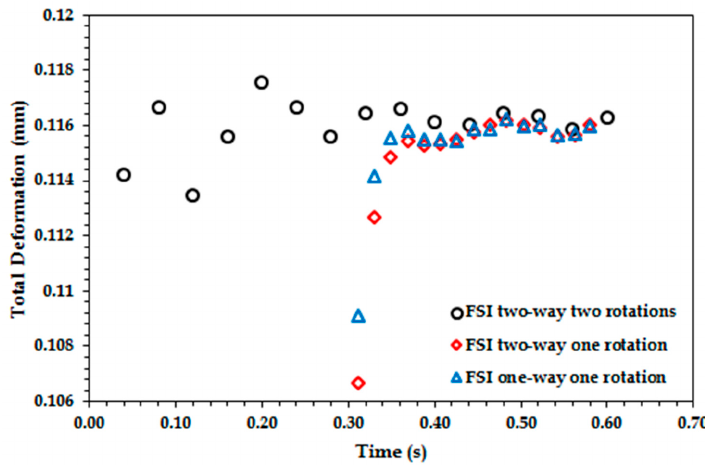
Figure 3. Prediction of total deformation from the three FSI simulations.